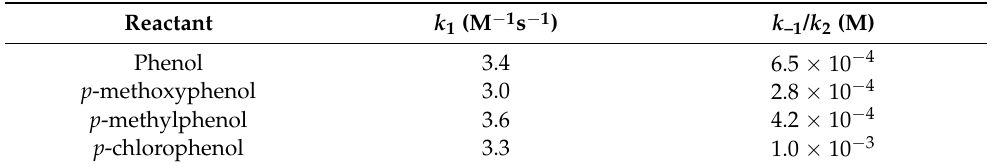
Table 1. Kinetic parameters for the reaction of rMb(Co III Cor) with hydrogen peroxide in the presence of phenol and its derivatives 1 .